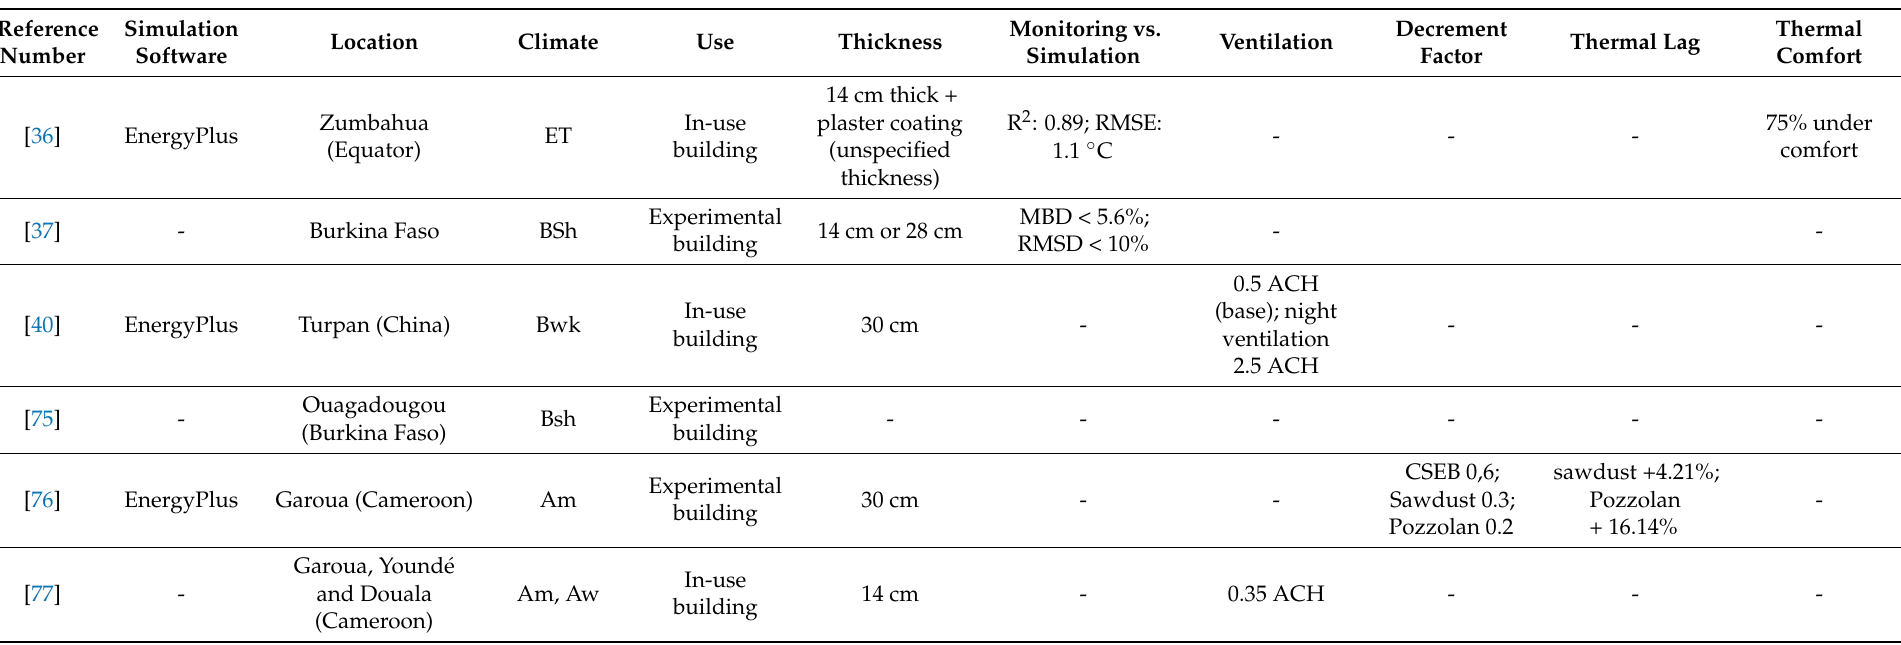
Table 9. Building characteristics and thermal performance of the compressed earth blocks simulated